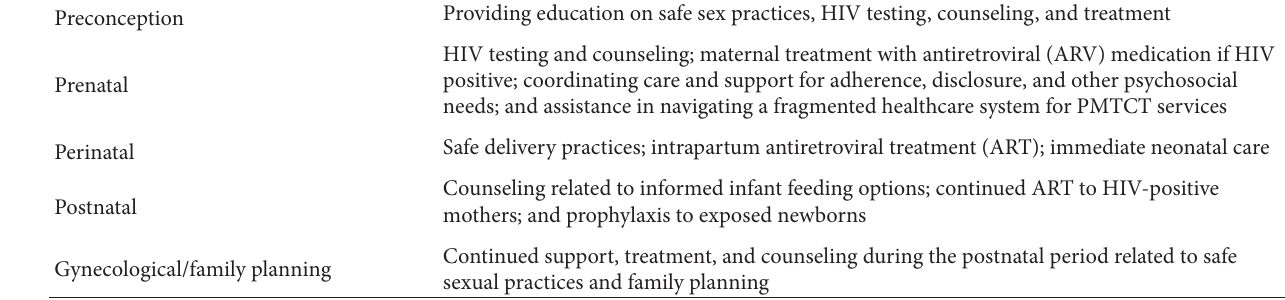
Table 1: The role of nursing in preventing maternal to child transmission of